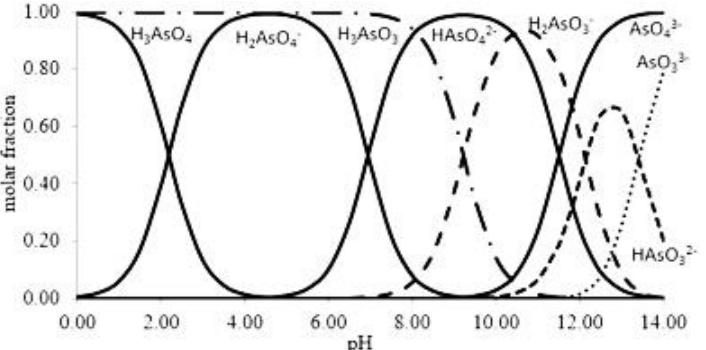
Figure 1. Speciation of As (III) and As (V) as a function of pH. Reprinted from Ungureanu et al. [14] Copyright 2021 Elsevier (Ungureanu et al., 2015).